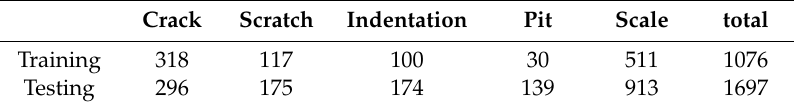
Table 1. Type composition of surface defect sample sets.